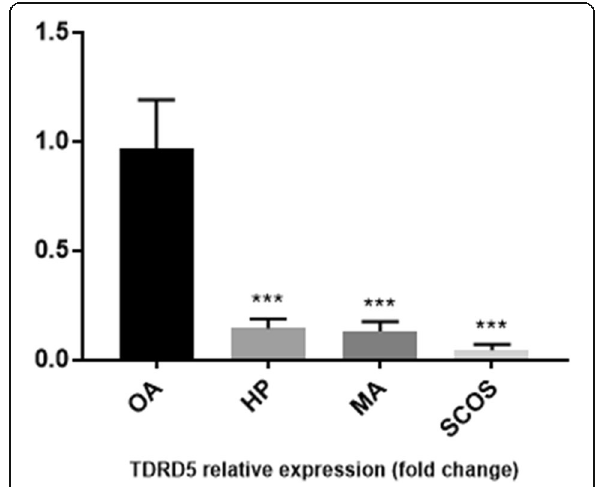
Fig. 5 Comparison of the expression levels of TDRD5 between HP, MA, SCOS, and OA(control) patients. *** p <